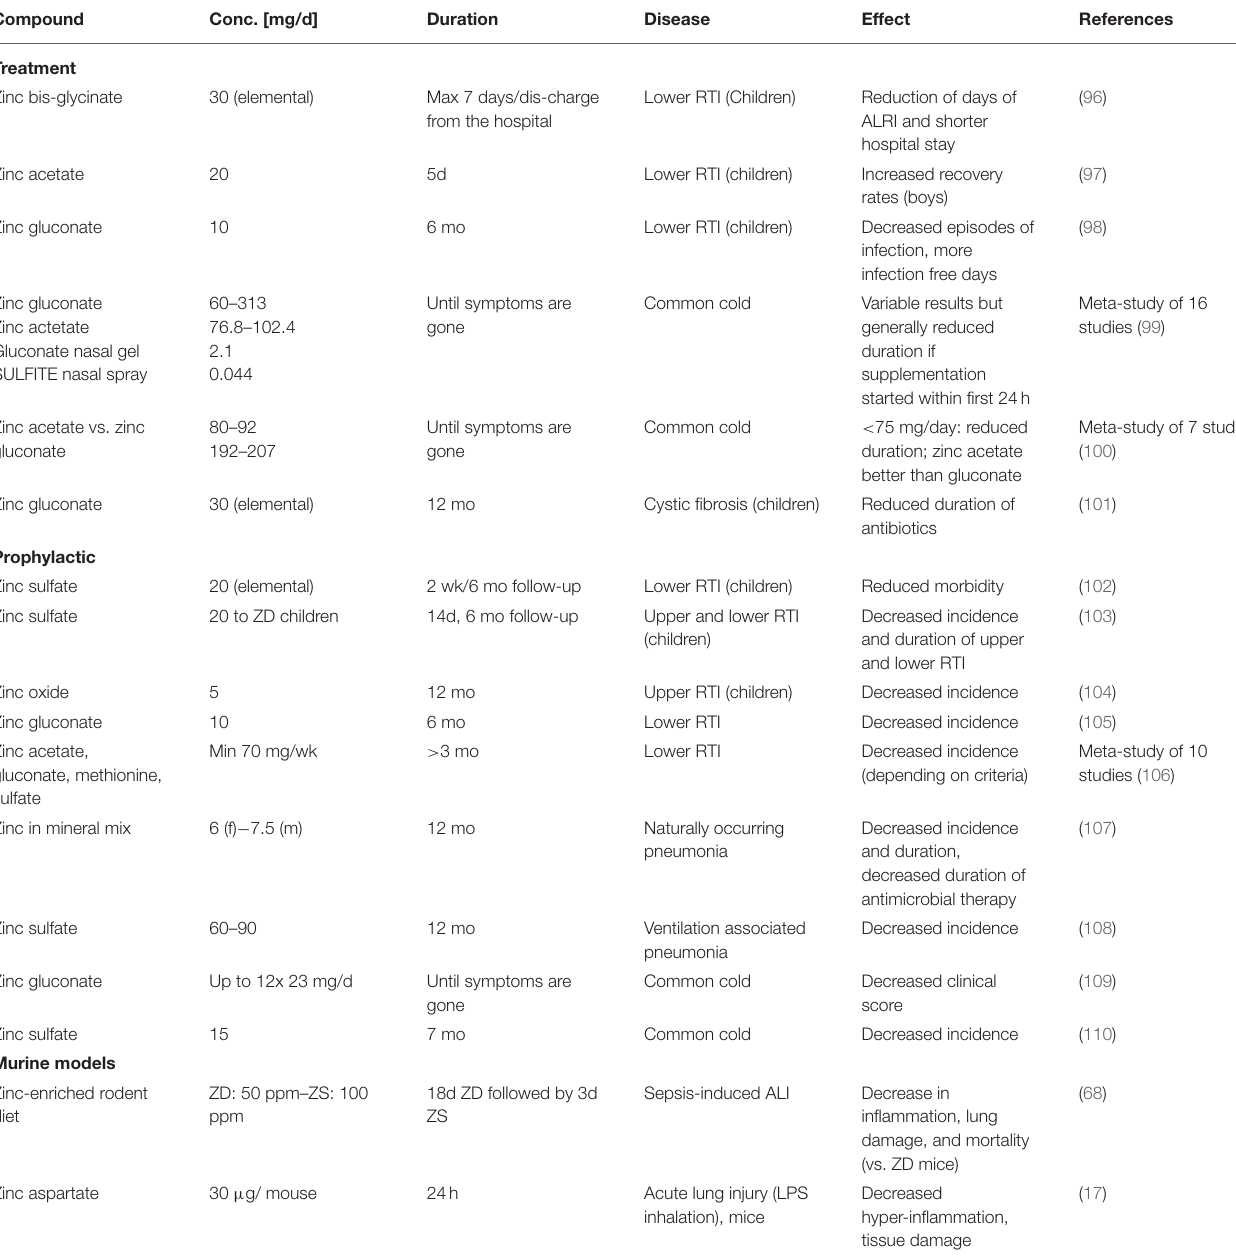
TABLE 1 | Selected zinc supplementation studies in respiratory